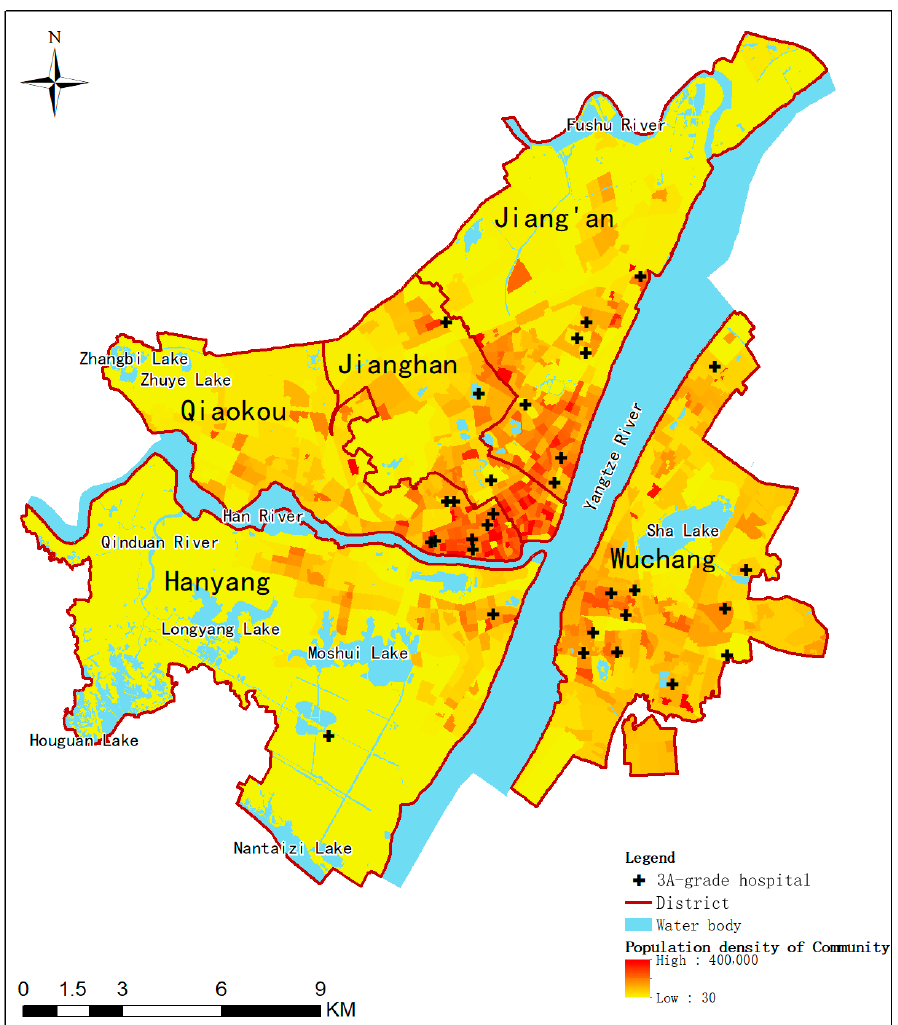
Figure 2. Spatial distribution map of five districts of Wuhan (China), 2022.